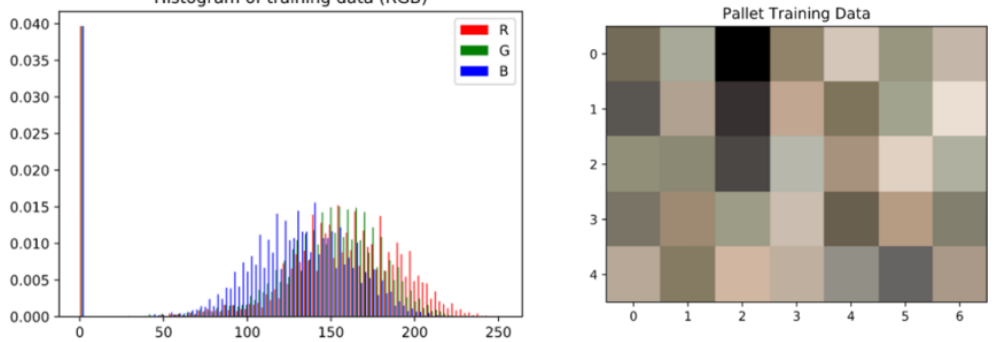
Figure 3. RGB color histrogram of training samples and the 35 most prominent colors of the